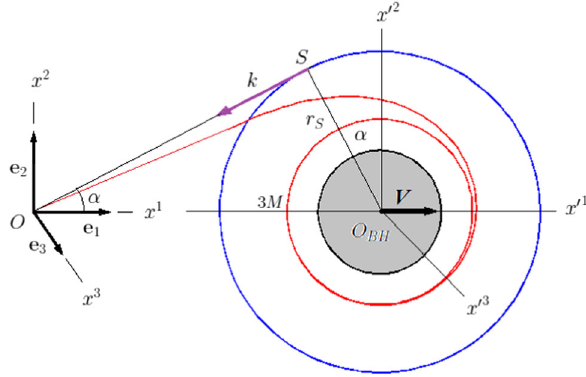
Fig. 3 The geodesic r ( + ) (φ) observed as a rectilinear de Sitter one of a photon of momentum k emitted by the apparent source S situated on √ the sphere of radius r S > 3 3